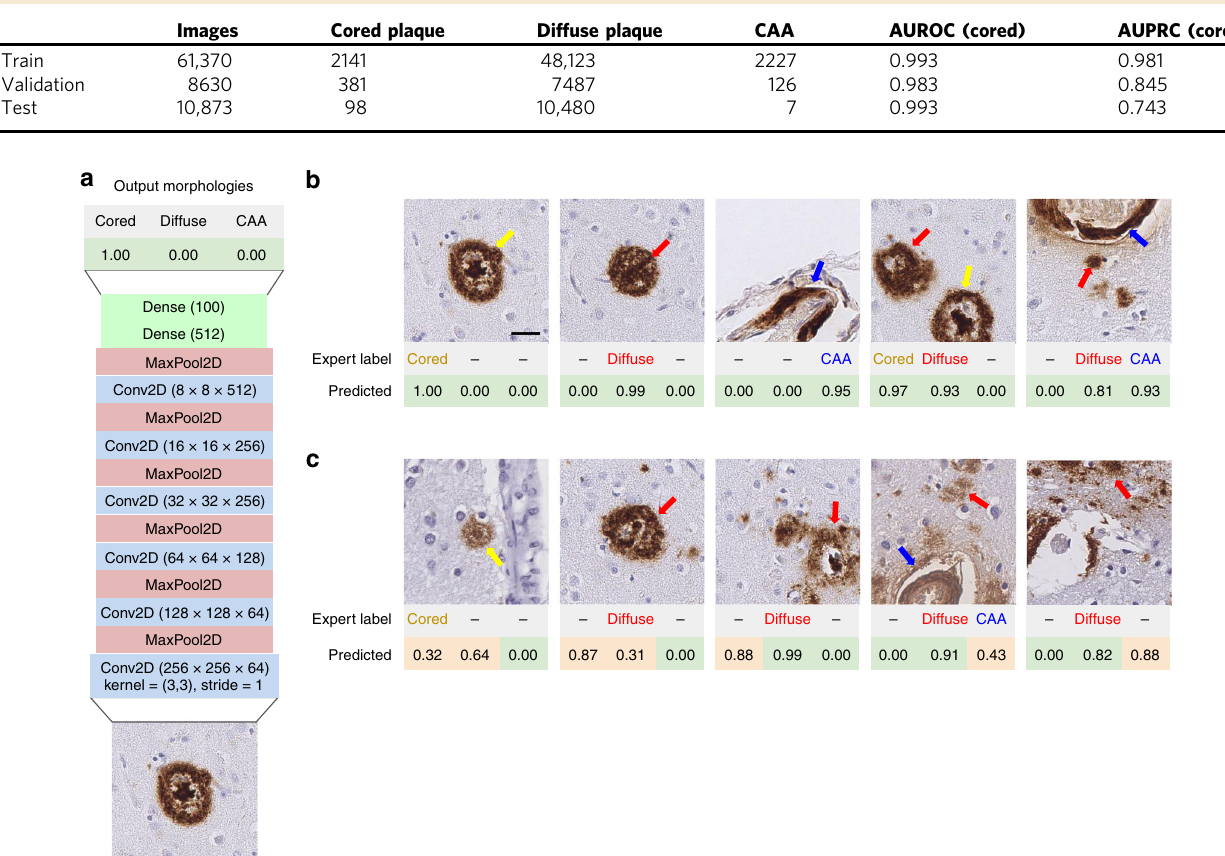
Fig. 3 CNN models identify three A β deposit types in image tiles. a The optimized CNN model architecture contained six convolutional layers and two dense layers, using exclusively 3 × 3 kernels and alternating max-pooling layers. b Examples of correct CNN predictions. The ground truth expert label row indicates the pathologies that had been manually found within the tile image. The predicted row shows corresponding model con fi dences for cored plaque (yellow arrow), diffuse plaque (red), and CAA (blue) classes (from left to right). Model predictions range from 0.00 to 1.00, where a higher score indicates higher predicted con fi dence by the CNN for that plaque class (e.g., the 1.00 corresponds to 100% model con fi dence that a cored plaque is present in the leftmost panel). c Examples of CNN predictions that do not agree with the expert manual annotation. Incorrect model predictions are indicated by light orange backgrounds in the predicted column; green backgrounds correspond to correct predictions. Scale bar = 25 μ m for all